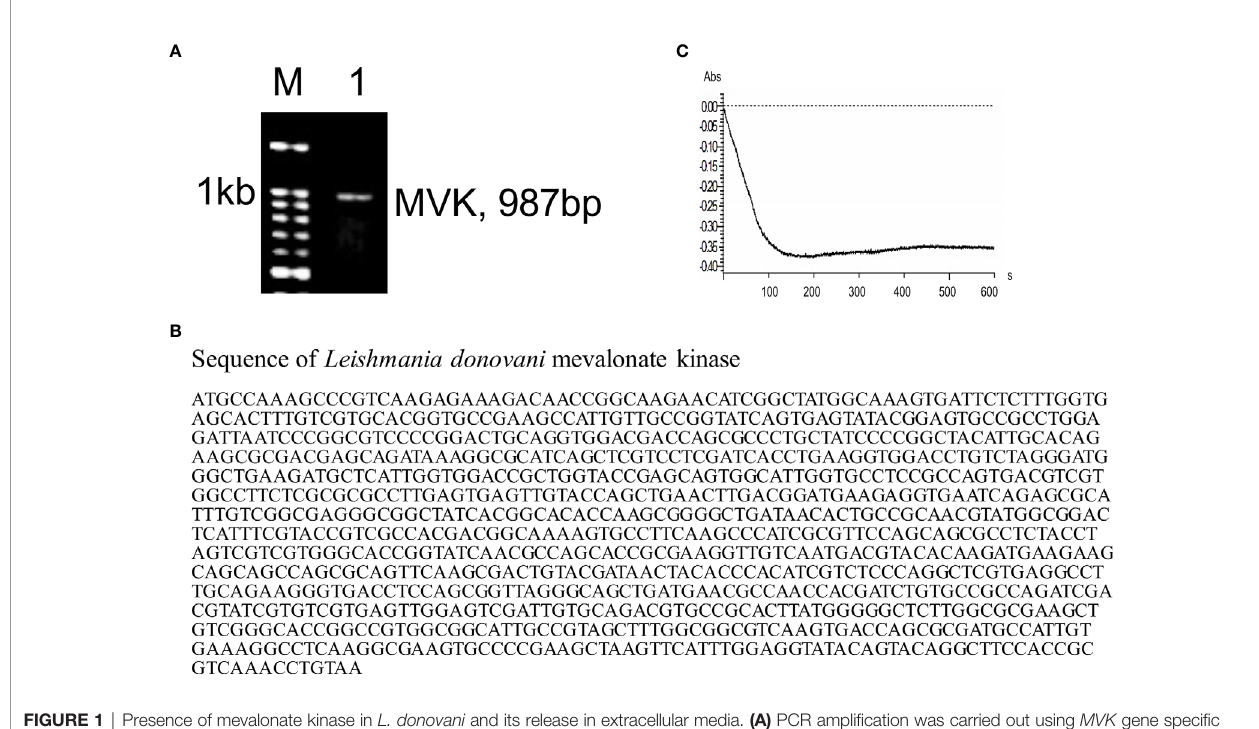
FIGURE 1 | Presence of mevalonate kinase in L. donovani and its release in extracellular media. (A) PCR ampli fi cation was carried out using MVK gene speci fi c primers and L. donovani Ag83 strain genomic DNA as template to reveal its presence in the parasite. Kb, kilobase; M, DNA ladder; 1, MVK-PCR product. Similar results were obtained from at least two independent experiments. (B) The PCR fragment ampli fi ed using MVK gene speci fi c primers was sequenced using di-deoxy sequencing and full length MVK gene sequence was obtained. (C) Parasite was incubated in serum-free medium for 6 h at 37°C and culture supernatant was collected and concentrated. The concentrated supernatant consisting of released proteins was checked for the presence of MVK by mevalonate kinase assay. Decrease in absorbance due to NADH oxidation relates to increased MVK activity. Representative image of at least three independent experiments is shown. Blank assays were performed with centricon concentrated incomplete